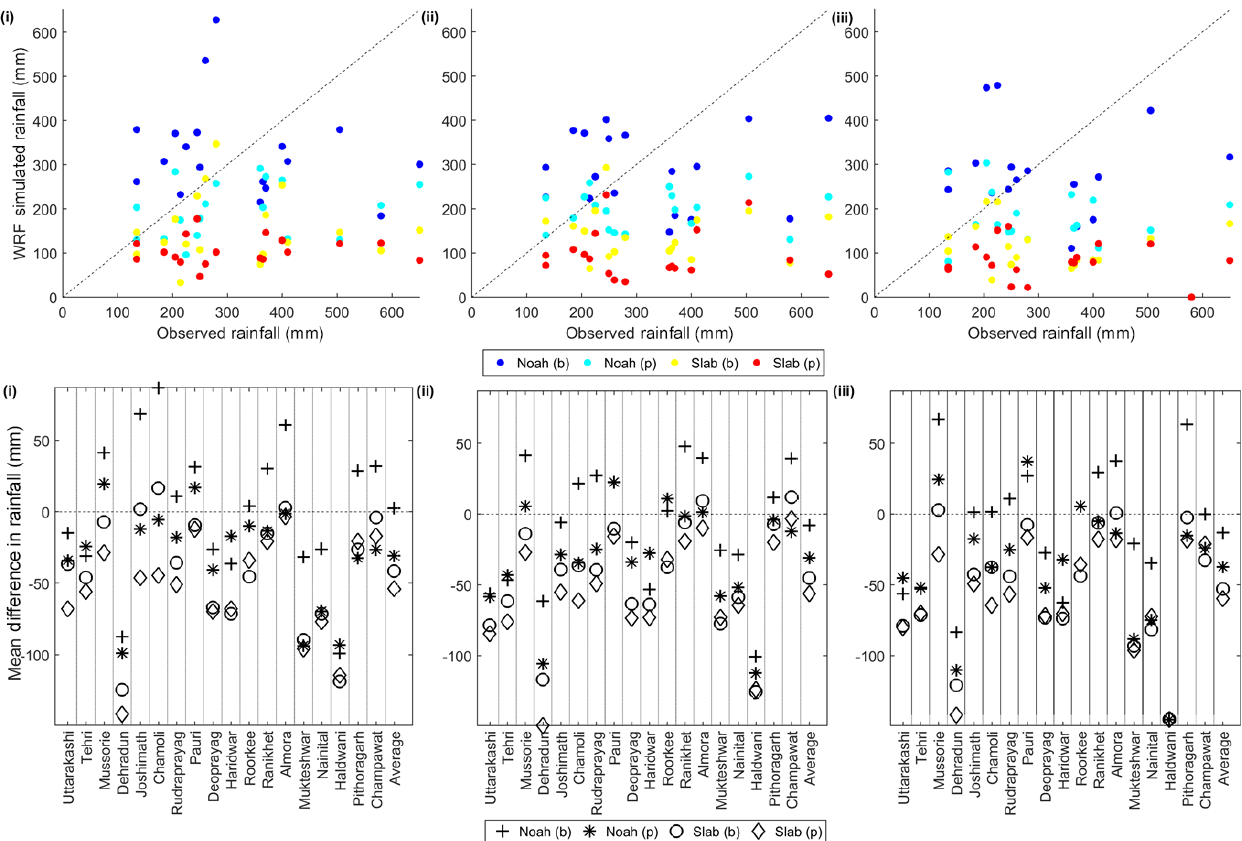
Figure 11. Scatter plot (top panels) and mean difference in rainfall (bottom panels) for the observed rainfall data and the WRF simulations (for (b) and (p) configurations) pertaining to Noah and Slab LSMs corresponding to (i) Domain 1, (ii) Domain 2a and (iii) Domain